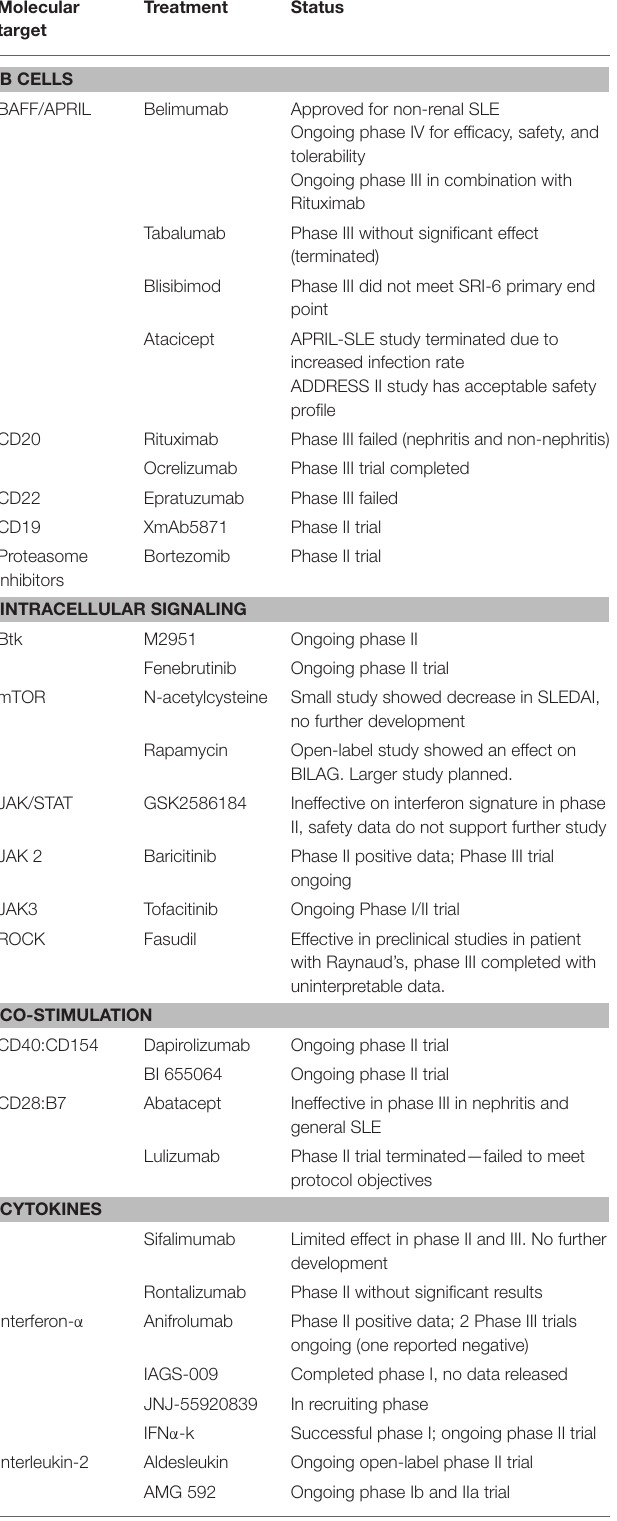
TABLE 1 | New and emerging therapies in SLE. Molecular